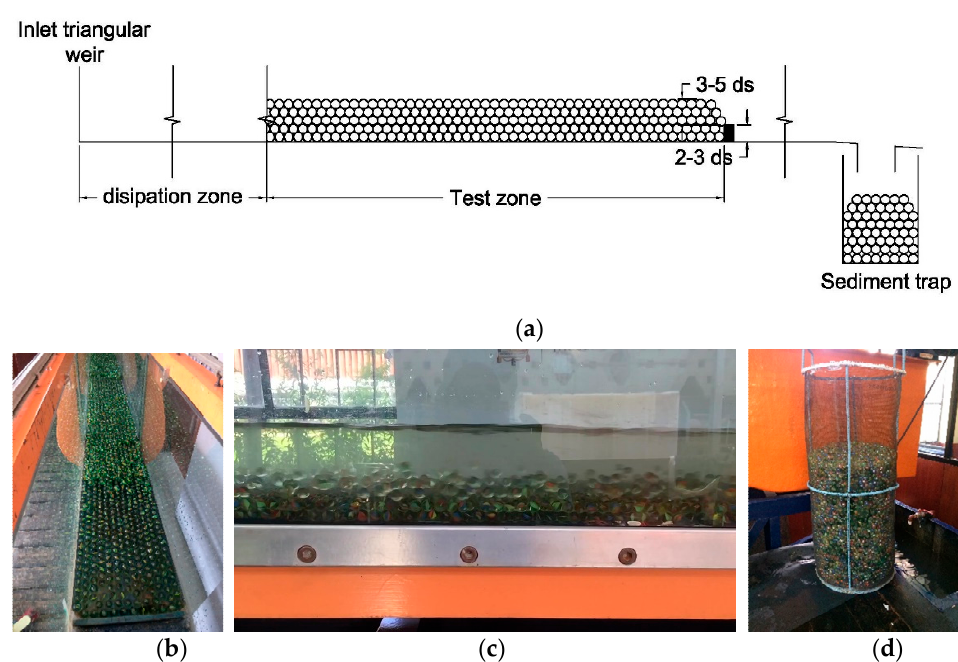
Figure 2. ( a ) Schematic of the simulation configuration, ( b ) test zone prepared for a simulation, ( c ) test zone during a simulation, and ( d ) sediment trap with the sediment collected in a simulation. Table 2. Simulation parameters.